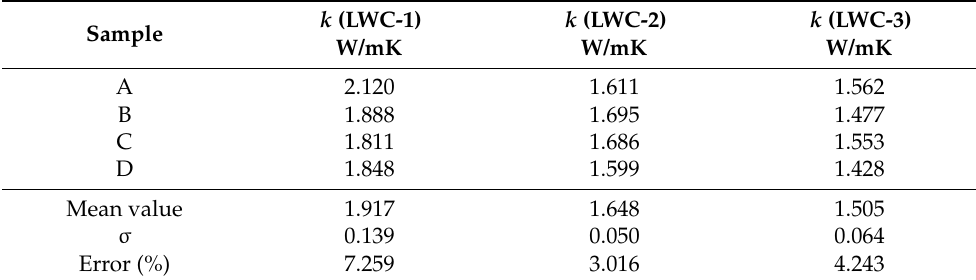
Table 4. Fitted values of thermal conductivity for 7% of moisture content.